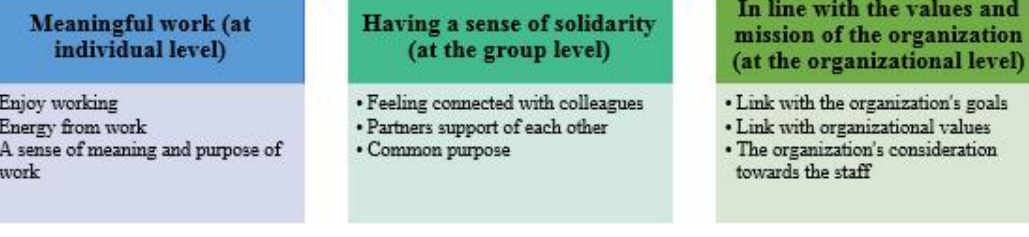
Fig. 1: The dimensions of spirituality in the workplace (Milliman et al .,